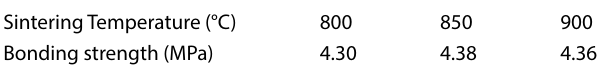
Table 1 The bonding strength of coating at different sintering tem-